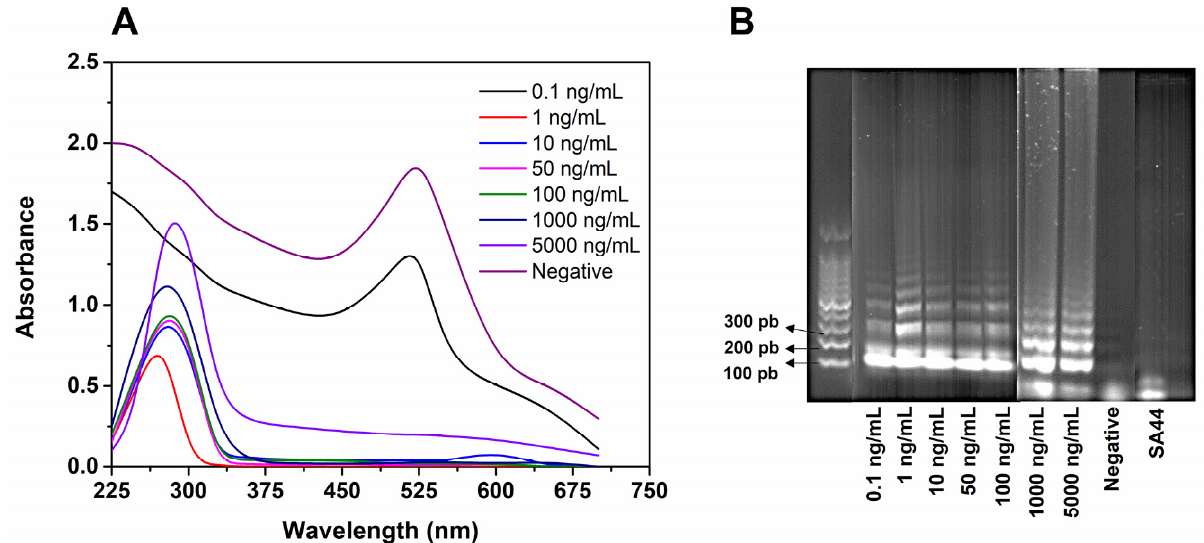
Figure 6. ( A ) UV–Vis spectra for dynamic concentrations ranging from 0.1 to 50 × 10 3 ng mL − 1 of RNA of SARS-CoV-2 virus, negative control, and betacoronavirus SA44. ( B ) Electrophoresis with 1% agarose gel confirming distinct concentration of RNA amplification and identification of amplified fragment in the target range of 100 to 200 bp.